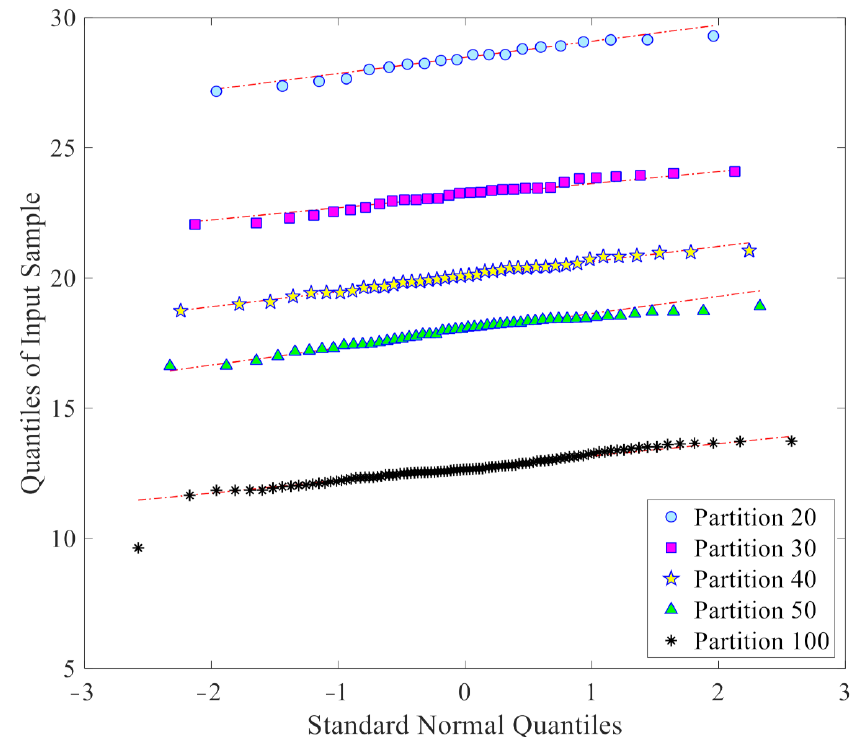
Figure 7. ASCE problem: normality assessment through Q-Q plots of the l 2 -norm values in d u , at varying number p of the